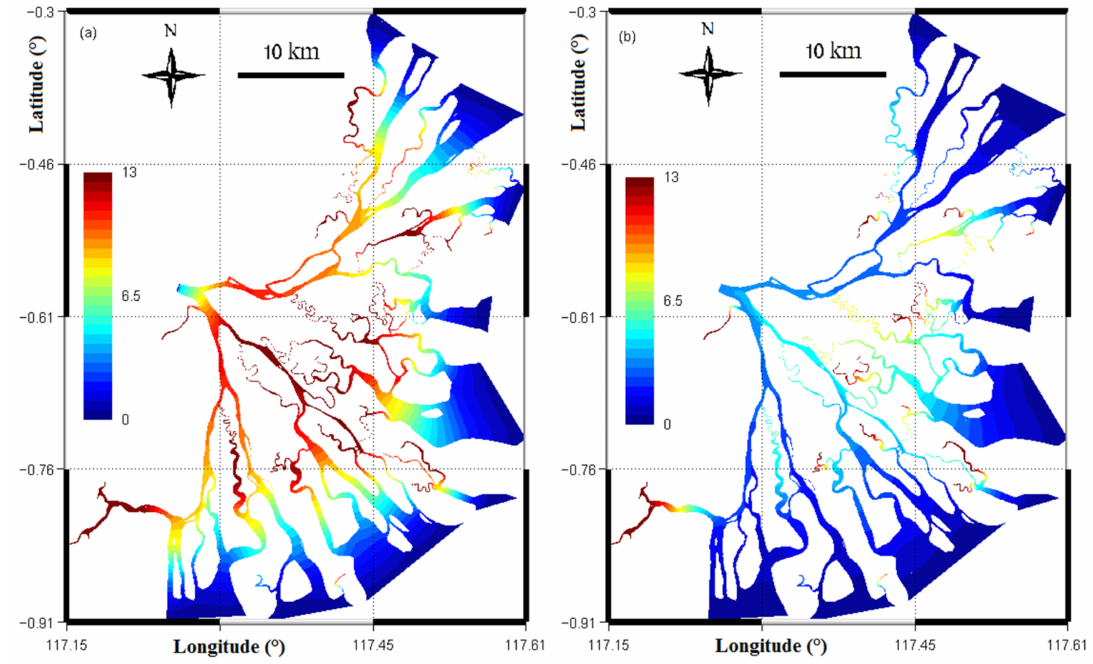
Figure 11. Distribution of the residence time in the whole delta for the: ( a ) low; ( b ) high flow period. The color bar is cropped at 13 days in order to focus on the variation of the residence time in deltaic channels, and the unit is